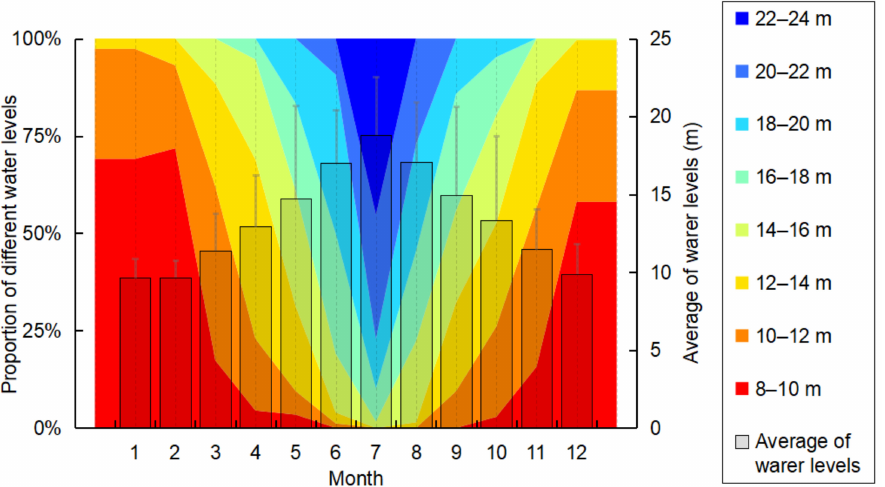
Figure 12. Frequency composition of different water levels per month (primary vertical scale) and monthly average water levels (secondary vertical scale) at the Hukou hydrological station from 1998 to